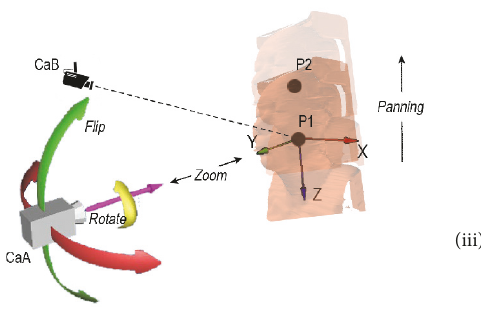
along the 𝑍 -axis (see the relationship between camera CaA and Slave model in Figure 4(a), and corresponding example (i) original camera view in Figure